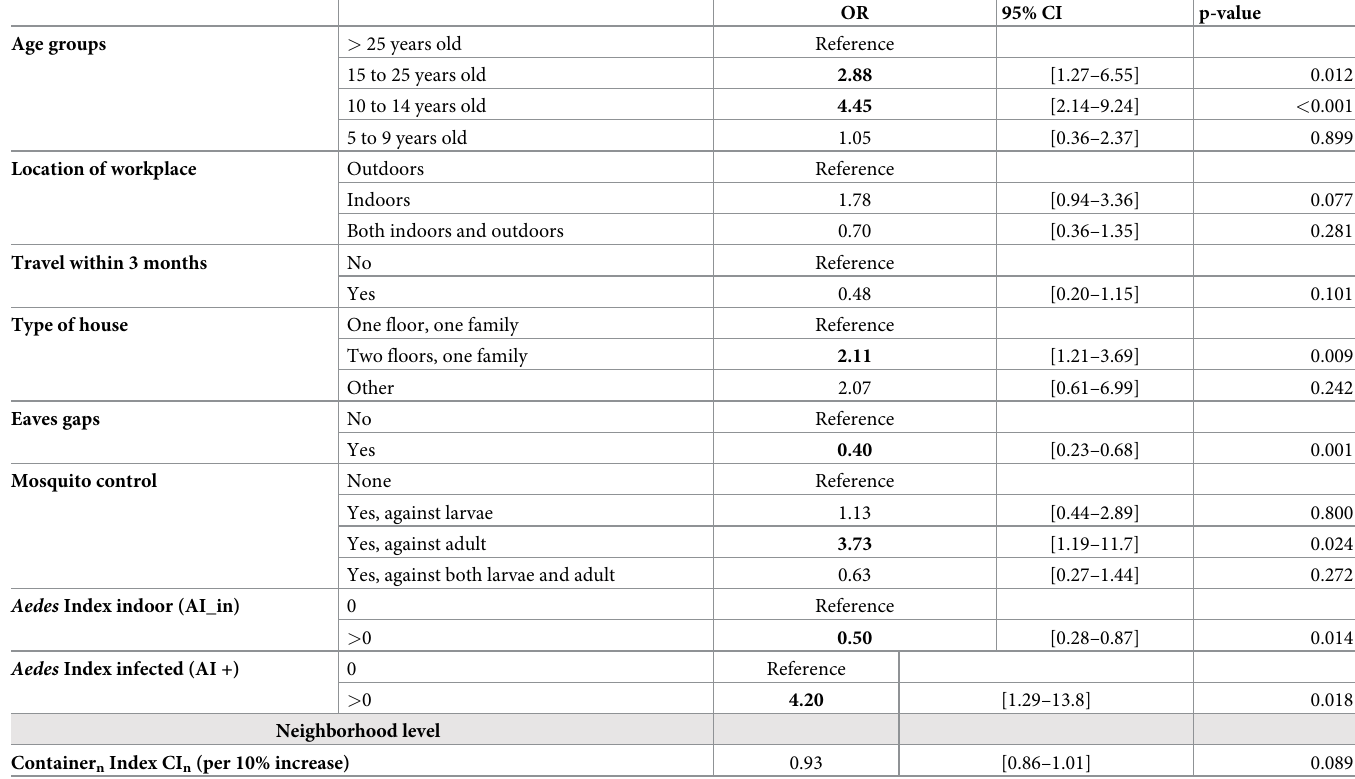
Table 3. Multivariable analysis of risk factors associated with dengue. Odds ratios (OR) were calculated by multivariable logistic regression and confidence intervals calculated using Wald’s statistics. Odds ratio in bold text were significant at p <